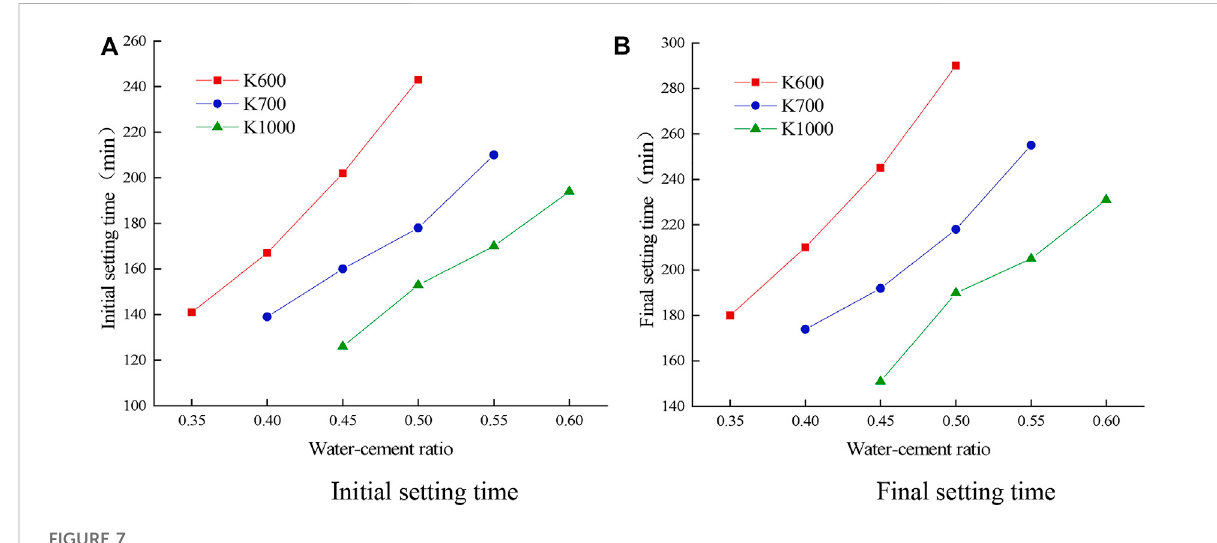
FIGURE 7 Setting time of super fi ne cement with different water-cement ratio.